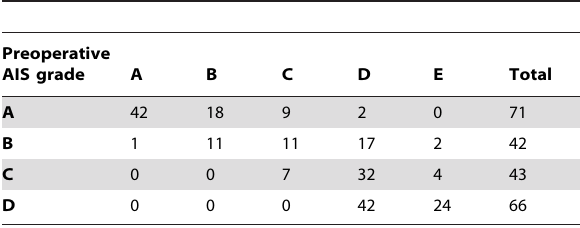
Table 3. Ordinal changes in AIS grade from pre-op to 6 months follow-up: Total Study Population.